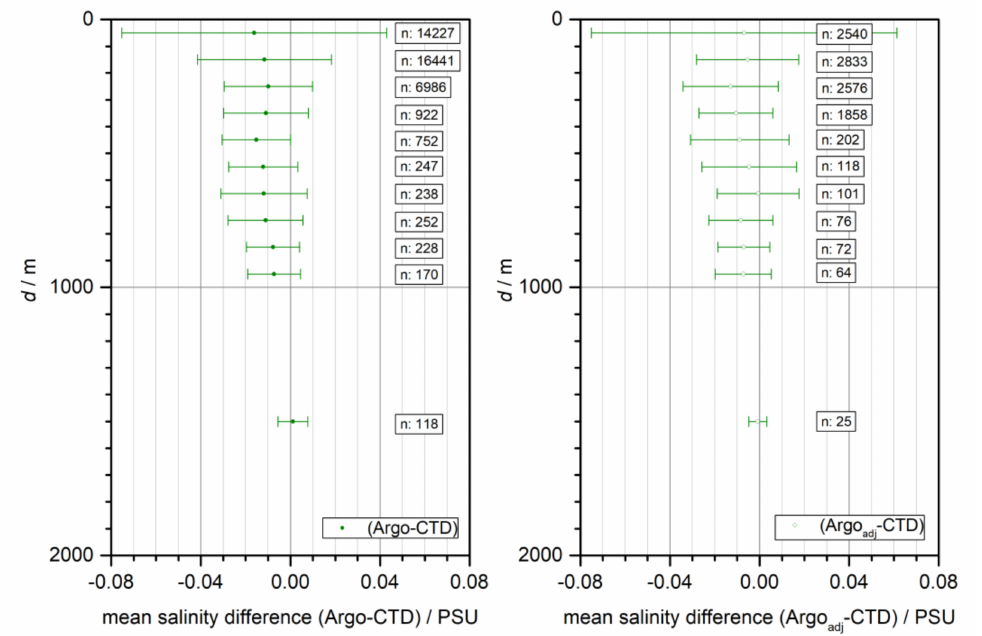
Figure 17. Mean salinity di ff erences and SD at depth intervals: Argo (not-adjusted, left , and adjusted, right ) vs.